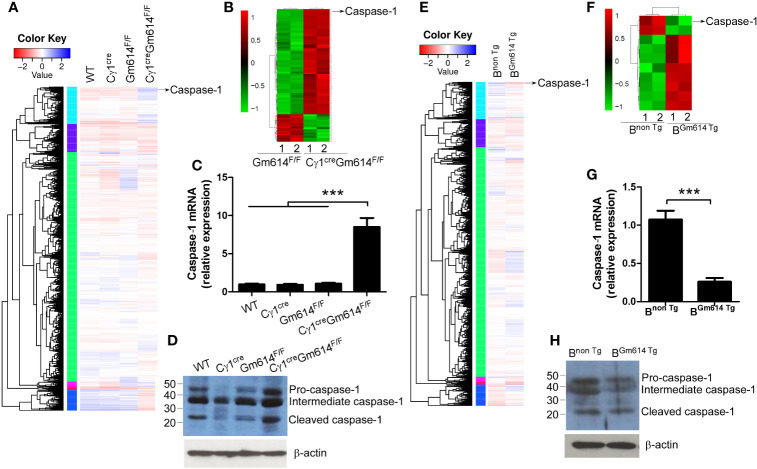
Gm614 suppressed caspase-1 expression in GC B cells. Nine-week-old WT, Cγ1cre, Gm614F/F, and Cγ1creGm614F/F
(A–D), or Bnon Tg and BGm614 Tg
(E–H) mice were i.p. injected with 0.5 ml pristane and 6 months after injection, splenic CD19+B220+CD38loGL7hi GC B cells were sorted by FACS. (A–D) Gm614 cKO up-regulated caspase-1 expression in GC B cells. The transcripts and proteomics in GC B cells were determined by RNA-sequencing (A) and iTRAQ quantitative proteomics (B), respectively, and caspase-1 is shown. Caspase-1 mRNA and protein expression in GC B cells were determined by qPCR (C) and western blot (D) assays, respectively. (E–H) Gm614 Tg suppressed caspase-1 expression in GC B cells. The transcripts and proteomics in GC B cells were determined by RNA-sequencing (E) and iTRAQ quantitative proteomics (F), respectively, and caspase-1 is shown. Caspase-1 mRNA and protein expression in GC B cells were determined by qPCR (G) and western blot (H) assays, respectively. (C, D, G, H) Data represent three independent experiments, with six samples per group per experiment. (C) One-Way ANOVA was followed by Bonferroni post-tests and (G) Student’s t-test (two tailed), Error bars, s.e.m., ***p < 0.001.